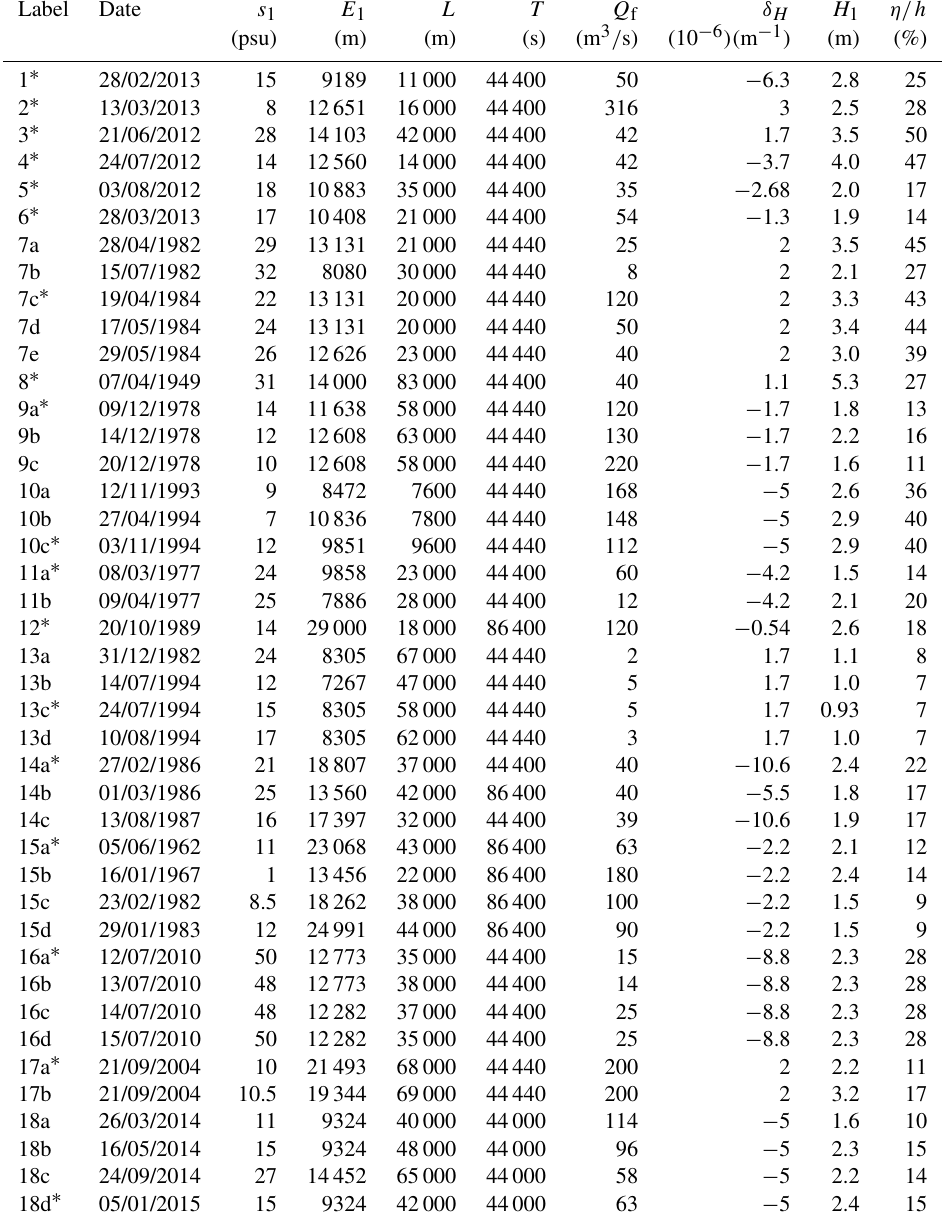
Table 2. Summary of salinity